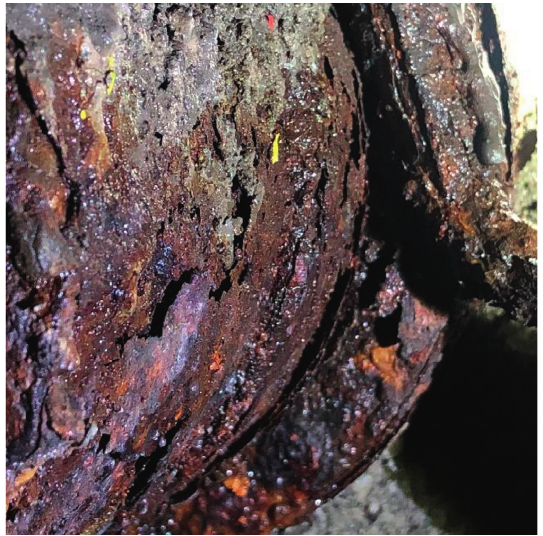
Figure 10: Severely rusted anchor head in the tailrace surge